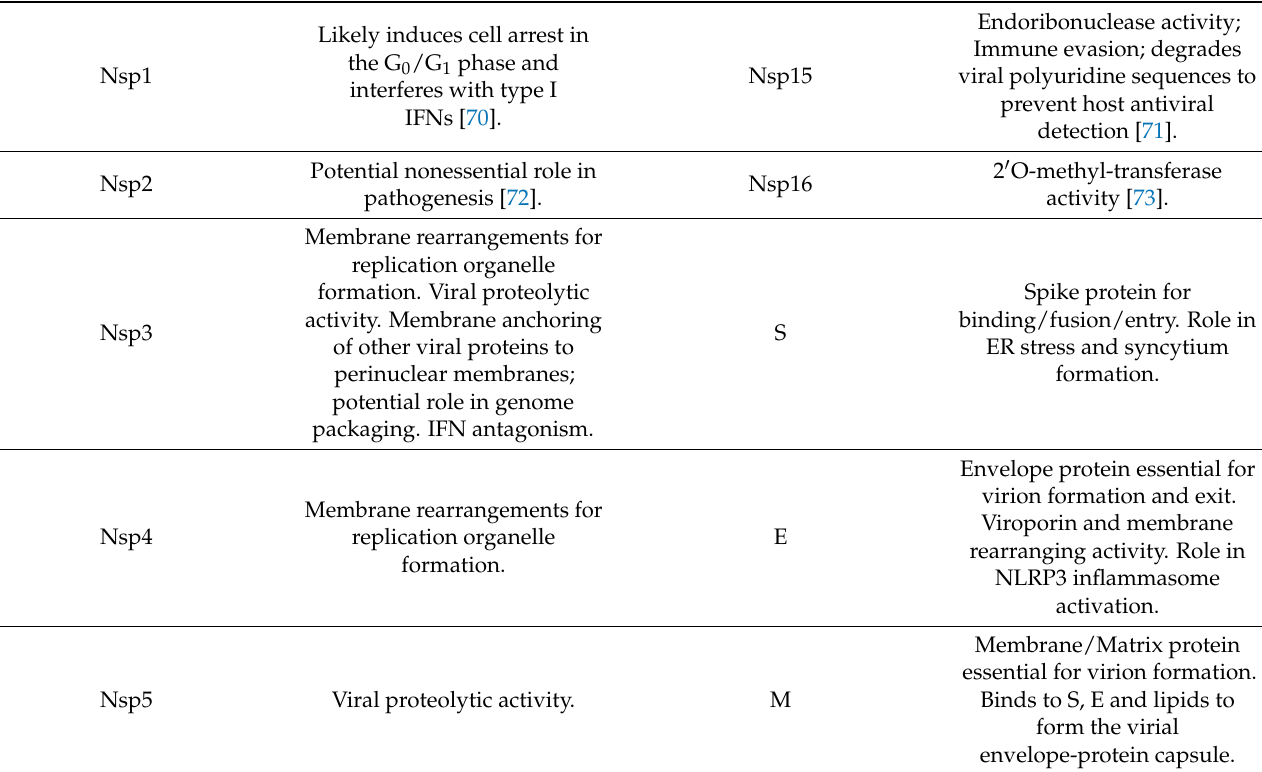
Table 1. Functions and properties of corona virus structural (S, E, M, N) and non-structural proteins (Nsps1–16) as well as ORFs 3a & b, 6a, 7a & b, 8a & b, and 9b.